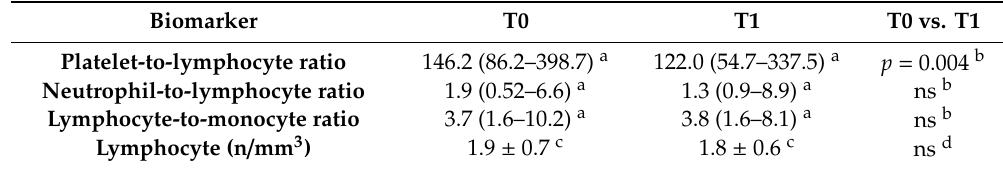
Table 10. Other biological markers of CKD